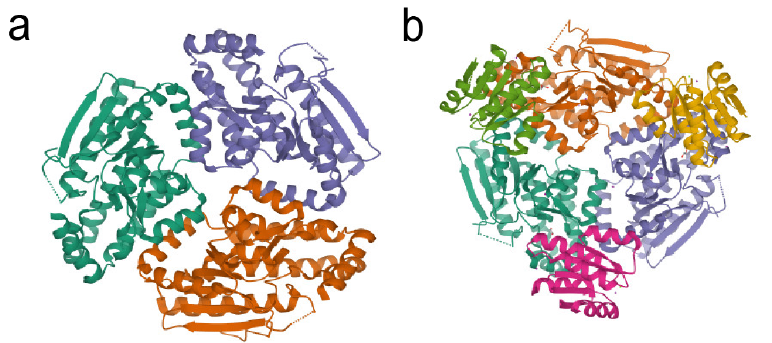
Figure 4. ( a ) 3D structure of the RpfF protein from Xanthomonas campestris pv. campestris. (PDB ID: 3M6N) ( b ) Crystal structure of RpfF, complexed with the REC domain of RpfC from Xanthomonas oryzae pv. oryzae . (PDB ID: 3M6M). The REC domain is shown in bottle ‐ green, bright orange, and purplish red. The pictures are from the https://www.rcsb.org website accessed on 1 November 2022.